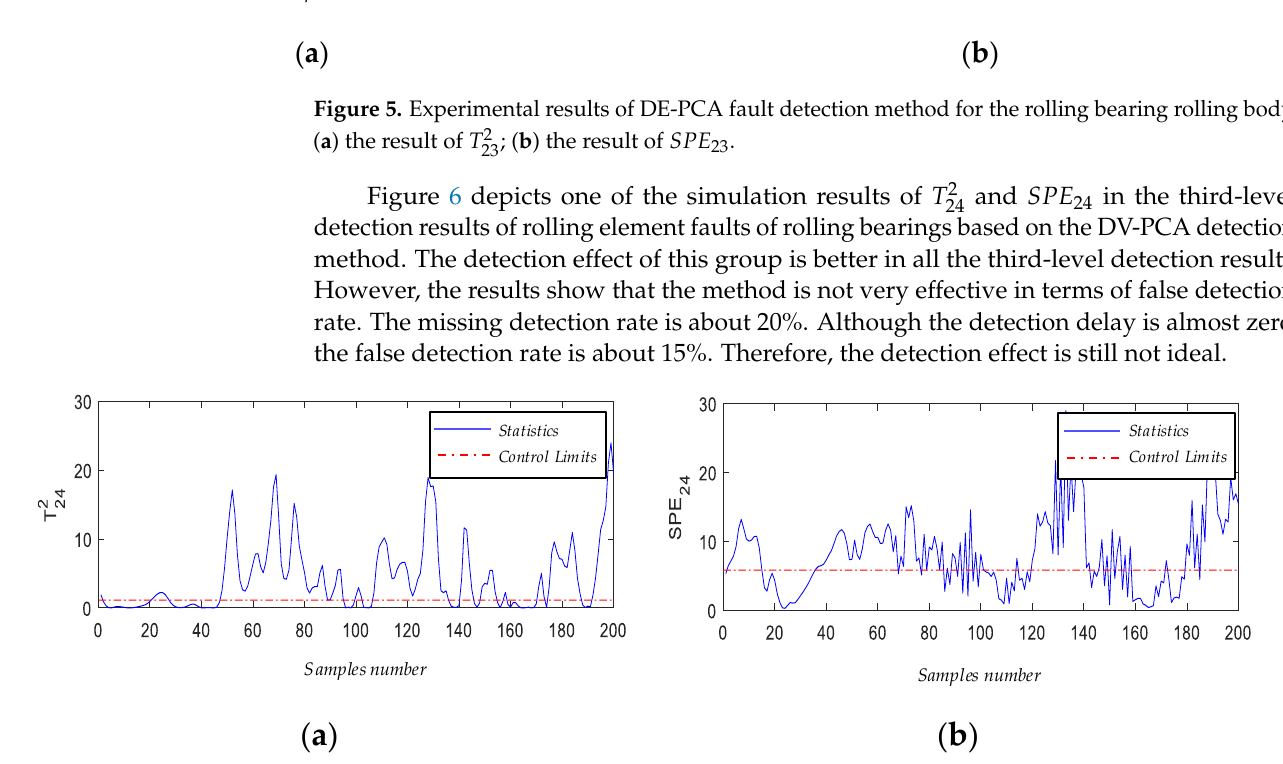
2 T ; ( b ) the result of SPE . 23 23